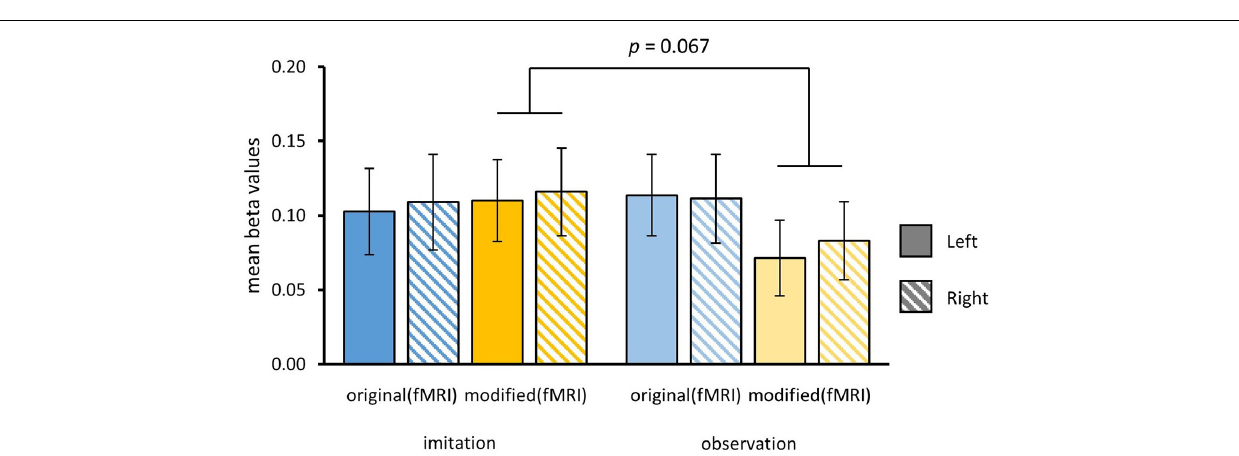
interaction in both HC for original and modified